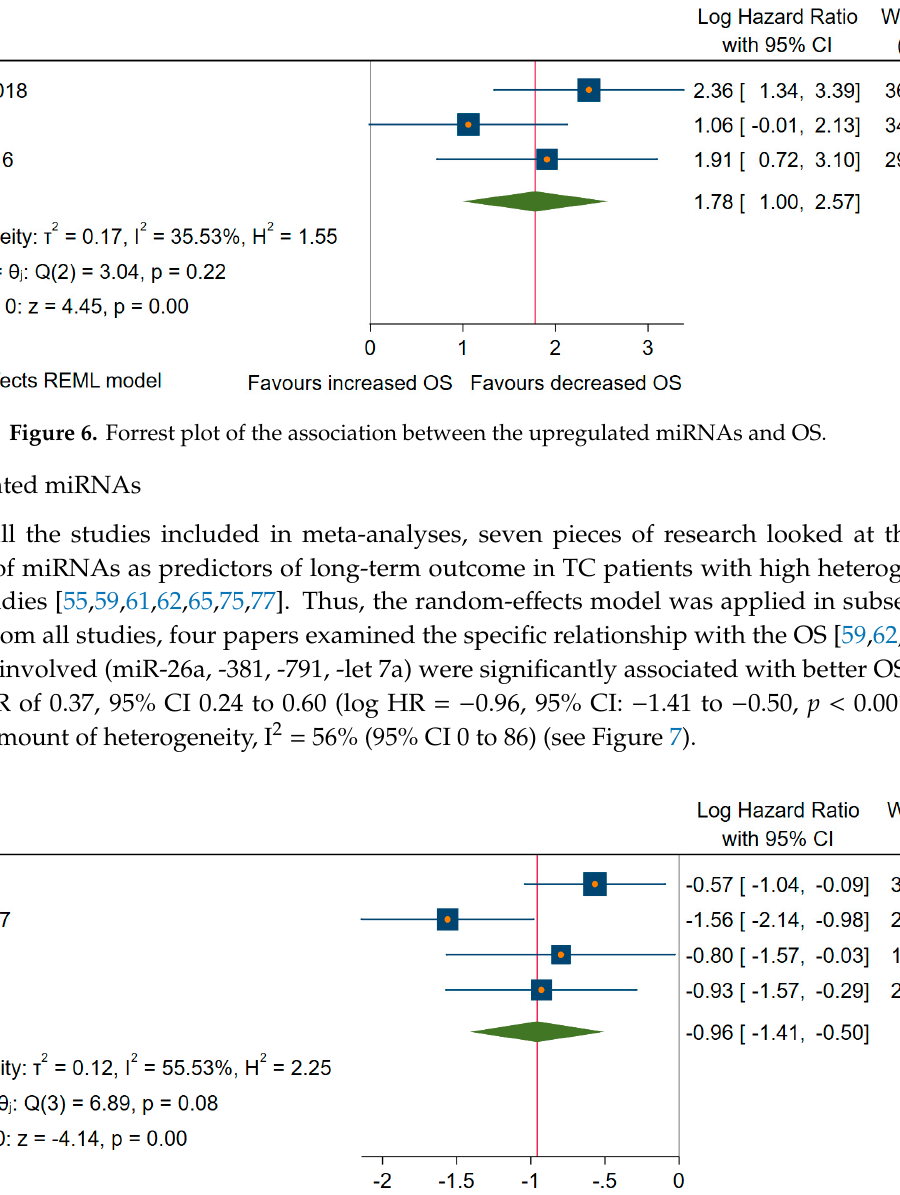
Figure 8. Forest plot of the association between the downregulated miRNAs and DFS/RFS. 3.6.2. Sensitivity Analysis by Specific Types of miRNA The amount of heterogeneity in the analysis of upregulated miRNAs and recurrence was dampened in sensitivity analyses when we estimated the pooled OR only for miR-221 (OR of 4.67, 95% CI 2.03 to 10.70; log OR = 1.54, 95% CI: 0.73 to 2.35, p < .001), I 2 = 19% (95% CI 0 to 88) and for miR-222 (OR of 7.63, 95% CI: 3.64 to 15.96; log OR = 2.03, 95% CI: 1.29 to 2.77, p < 0.001), I 2 = 0% (95% CI: 0 to 85) as well as for miRNAs of 221 and 222 as a family (OR = 5.924, 95% CI: 2.85 to 12.29; log OR = 1.78, 95% CI: 2.05 to 2.51, p < 0.001), I 2 = 0% (95% CI: 0 to 85) in conjunction with recurrence in all types of TC reported (PTC, MI-FTC), [63,64,73,76] (Figure 9). Estimations for mir-146b revealed a significant association with recurrence in PTC patients, which was the only subtype of TC reported in the four studies involved [64,69,73,76] (OR = 9.11, 95%